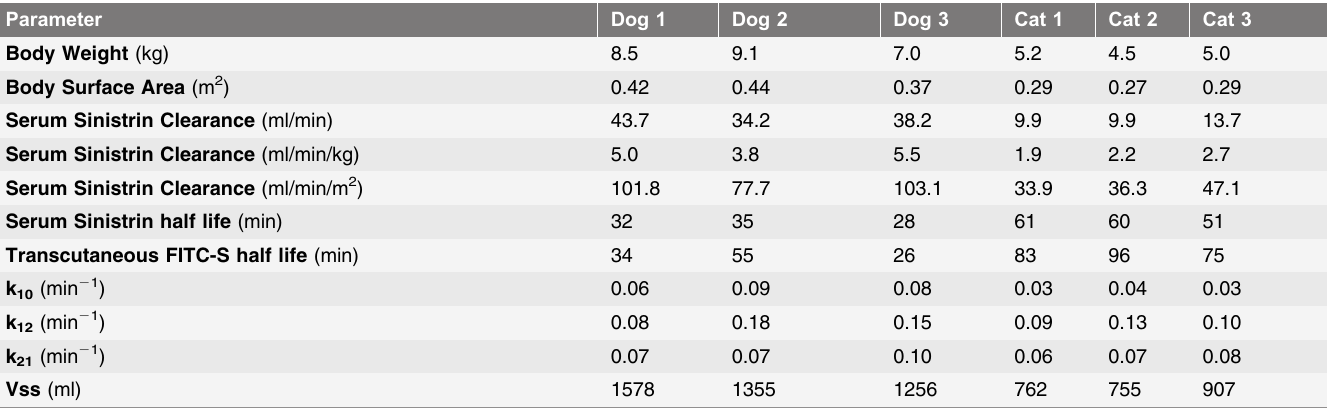
Table 2. Results of serum sinistrin and transcutaneous fluorescein-isothiocyanate-labelled sinistrin clearance in all animals studied. Parameter Cat 3 Body Weight (kg) Body Surface Area (m 2 ) Serum Sinistrin Clearance (ml/min) Serum Sinistrin Clearance (ml/min/kg) Serum Sinistrin Clearance (ml/min/m 2 ) Serum Sinistrin half life